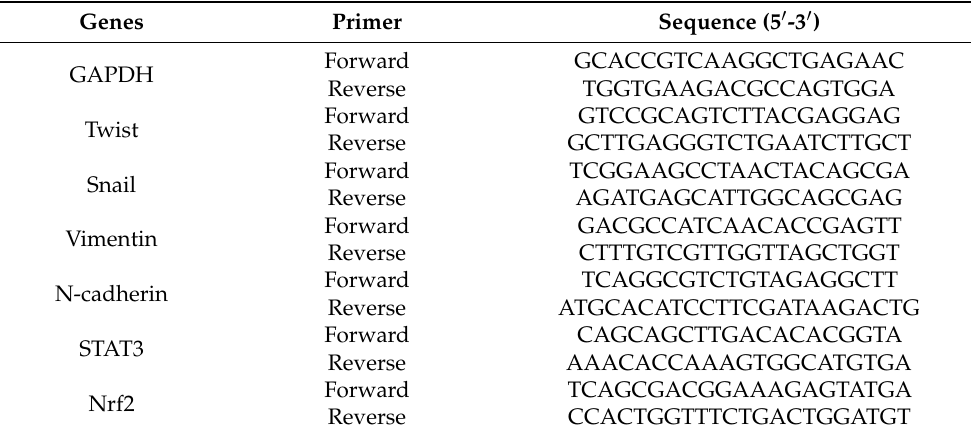
Table 1. Real-time RT-PCR oligonucleotide